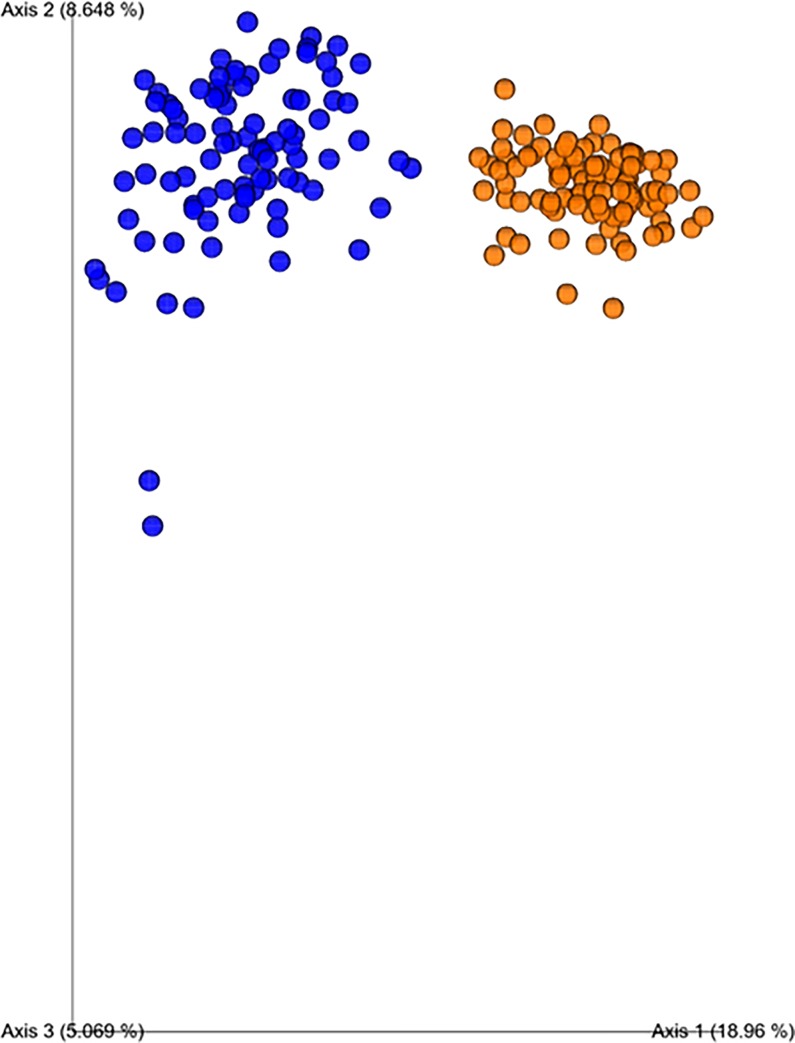
Principal coordinate analyses plot using unweighted UniFrac confirmed bacterial community differences centered on the bird’s age.(P<0.05, PERMANOVA, blue sphere = 21d, orange sphere = 42d).